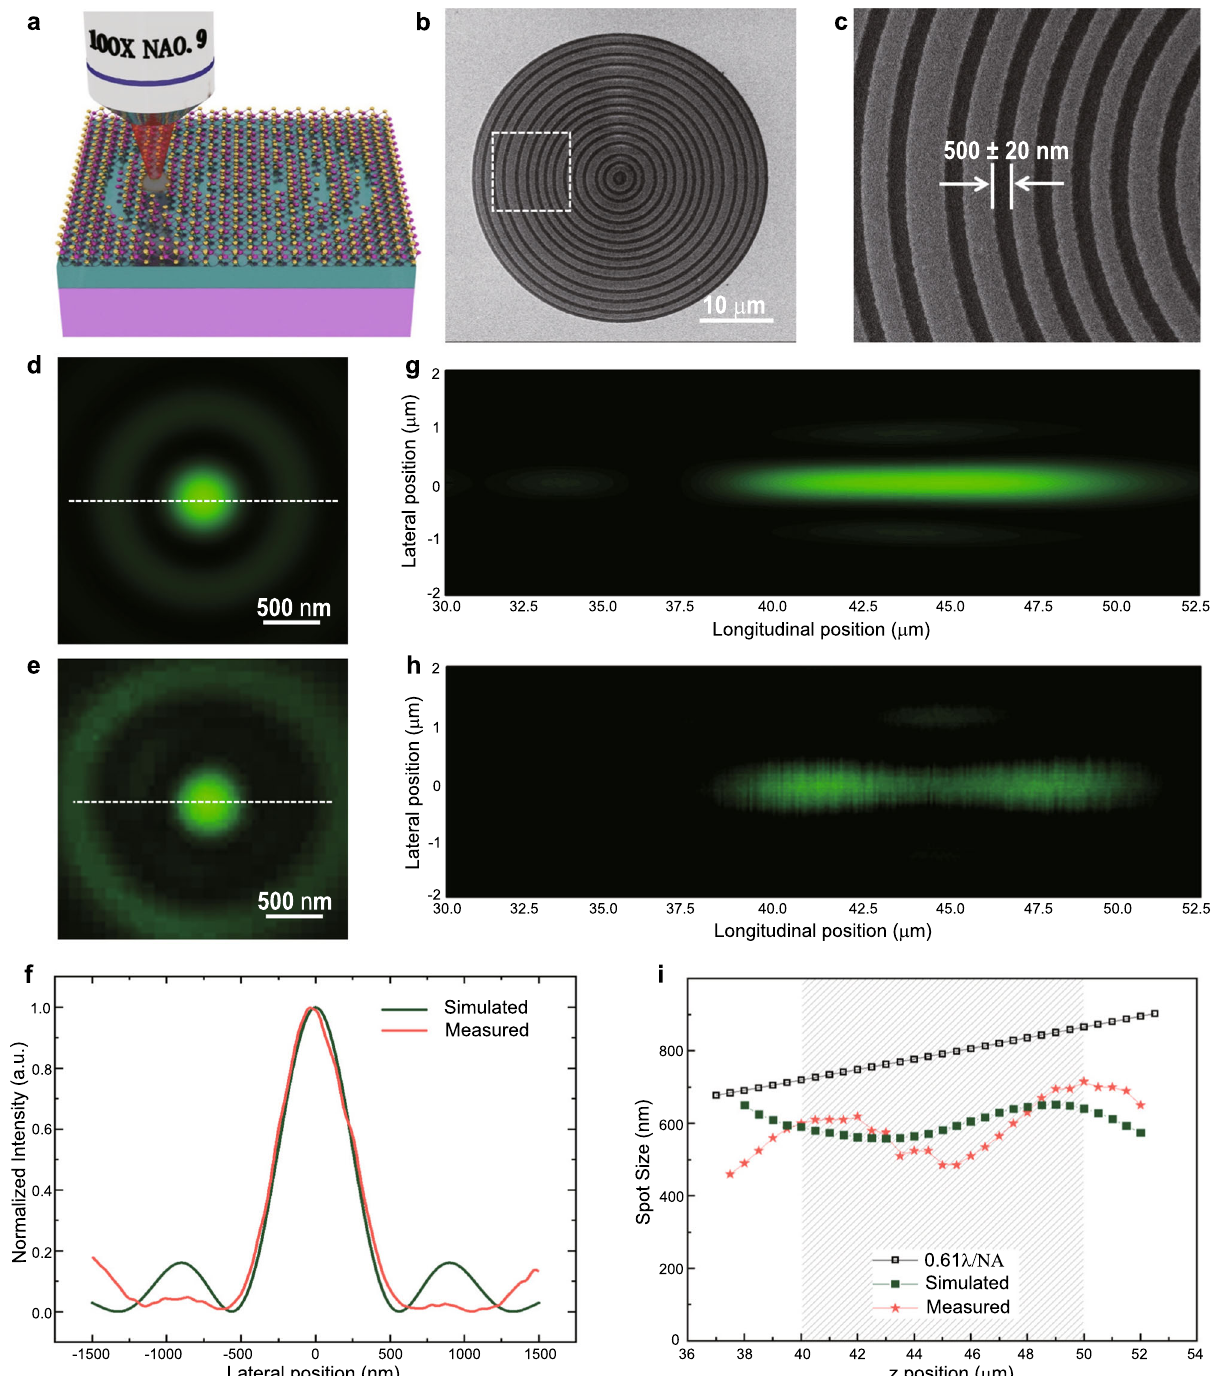
Fig. 3 Demonstration of a monolayer SCL with sub-diffraction-limited focusing. a Illustration of a binary phase-type SCL on a monolayer MoS 2 sheet obtained by fs laser scribing. b SEM image of an SCL on a monolayer CVD-prepared MoS 2 sheet. c Zoom-in view of the dashed box in ( b ), which depicts that the accuracy of the fs laser scribed belts can be controlled at ±20 nm. d , e Simulation and measured intensity distribution in the focal plane at a longitudinal position of z = 41 μ m, which is the brightest position along the needle in the experimental results. f Comparison of the line intensity pro fi les of the lateral size of focal spots between simulated and experimental results. g , h Theoretical and measured intensity pro fi les of the optical needle along the propagation distance in the region between z = 30 μ m and 52.5 μ m. i Comparison between the lateral sizes in the optical needle region and the Rayleigh criterion. The light shadow indicates the optical needle region. Olive green cubes, orange stars, and black open cubes depict the simulated spot size, measured spot size and Rayleigh Criterion,